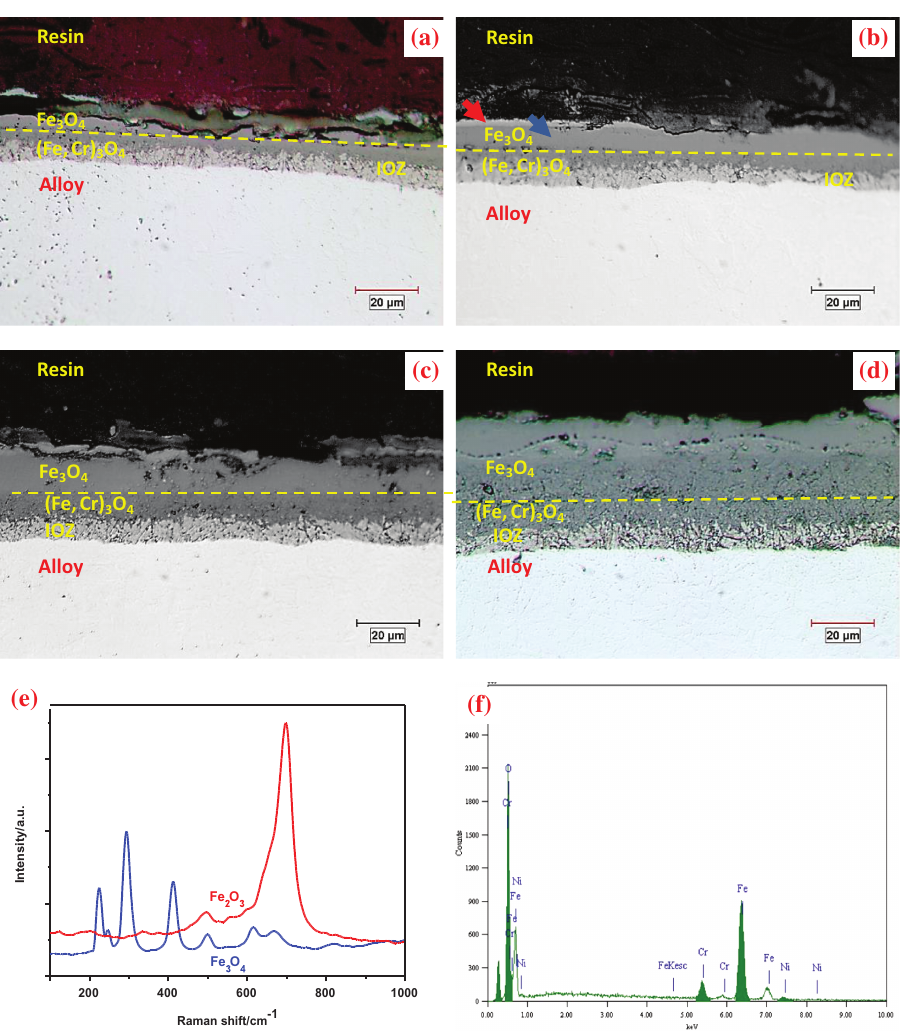
Figure 6: Cross-section morphologies of T92 steel with pre-oxidized finish after different times (a) 12.5h, (b) 25h, (c) 50h, and (d) 100h (e) Raman results in Figure 6(b) labeled in red and yellow arrows (f) EDS results of (Fe,Cr) 3 O 4 in Figure